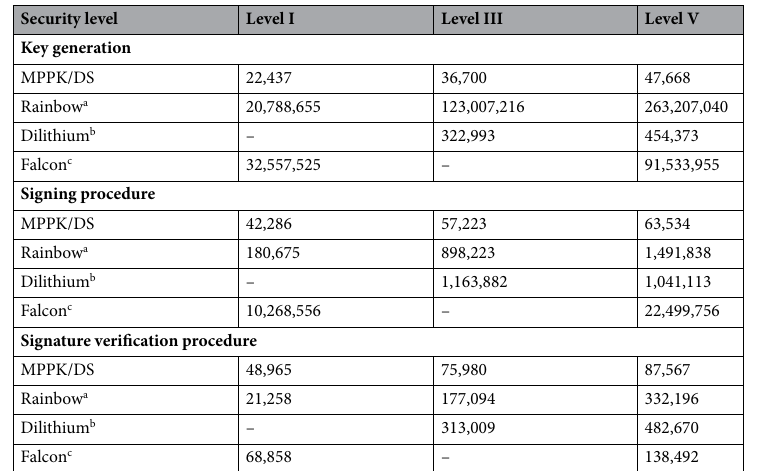
Table 4. Median values given in clock cycles, corresponding to the Performance measurement of the MPPK/DS scheme as well as the NIST PQC Round 3 Finalists for various NIST Security Levels. a The rainbow1aclassic363232 primitive was measured for Level I, rainbow3cclassic683248 for Level III, and rainbow5cclassic963664 for Level V. b Dilithium does not provide primitive for NIST Level I, dilithium3 was used for Level III, and dilithium5 for Level V. c For Falcon, falcon512dyn was measured for Level I, no primitive was measured for Level III, falcon1024dyn was measured for Level